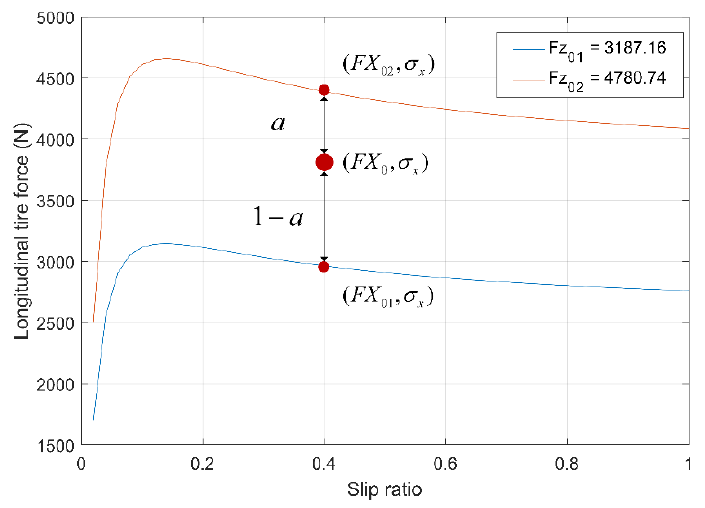
Figure 7. Reference curves of tire force in longitudinal direction. Here, FX 02 and σ x are the longitudinal force and slip ratio of the reference curve measured at Fz 02 = 4780.74 N. FX 01 and σ x are the longitudinal force and slip ratio of the reference curve measured at Fz 01 = 3187.16 N. The parameter a is a constant for the interpolation, which has a relation with the vertical force and slip ratio as (28).